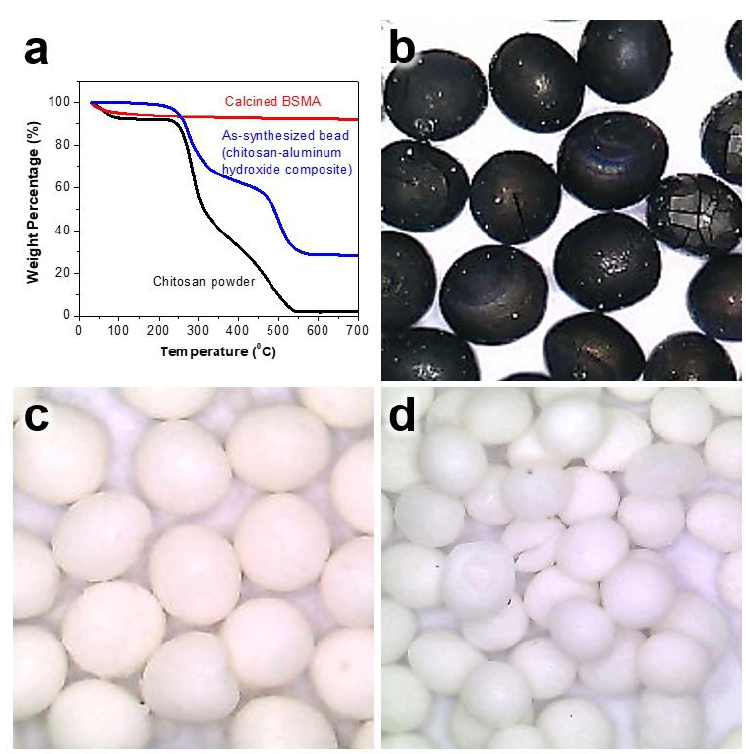
Figure 2. ( a ) TGA results of chitosan powder as a reference, as-synthesized bead and calcined BSMA sample at 600 °C. Digital photo images of BSMA samples calcined at various temperature: ( b ) 400 °C, ( c ) 600 °C and ( d ) 800 °C, respectively.